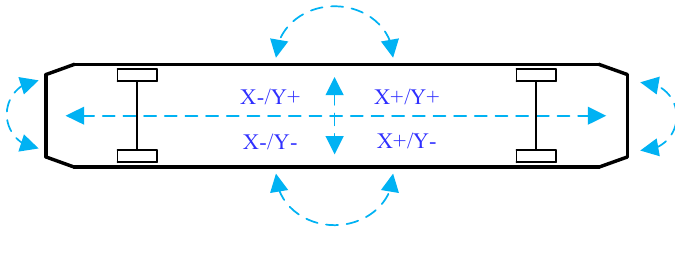
Figure 5. Control strategy of slave